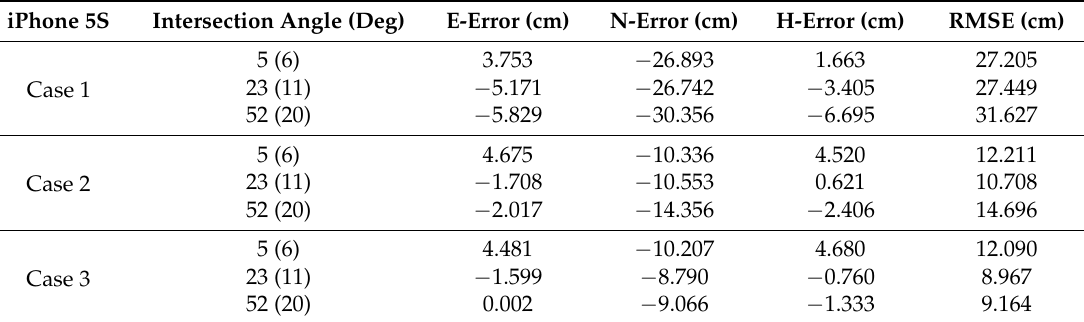
Figure 7. The used control points of intersection angle analysis for space resection. Table 2. The position error of intersection angle analysis for the iPhone 5S.